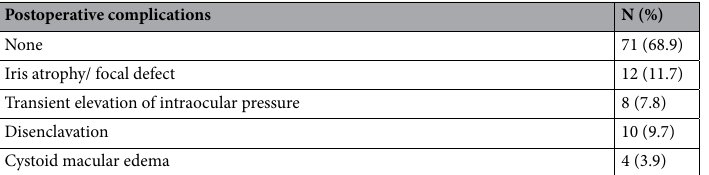
Postoperative complications N (%) None 71 (68.9) Iris atrophy/ focal